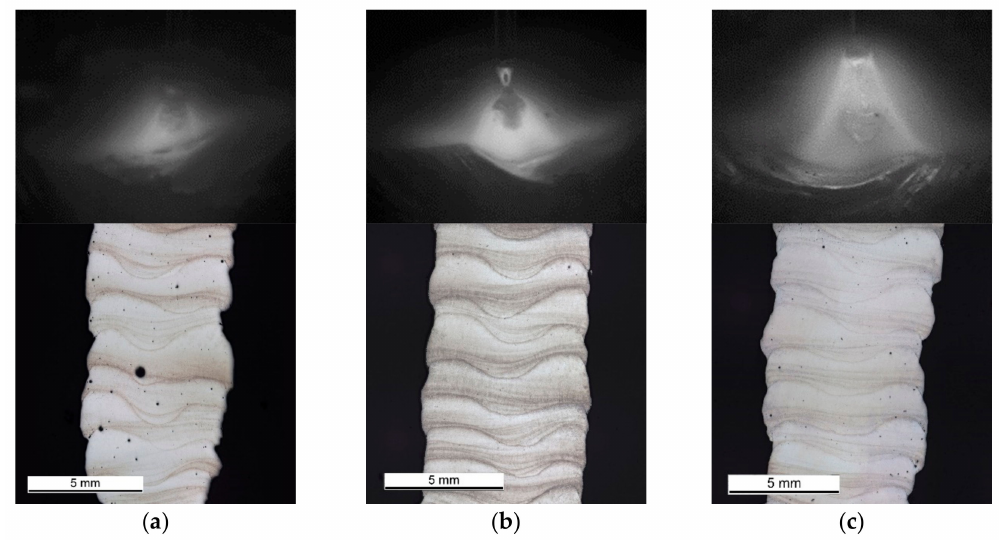
Figure 6. E ff ect of process adjustments on droplet transition and waviness of the structure: ( a ) negative arc and pulse corrections, ( b ) neutral settings, and ( c ) positive arc and pulse